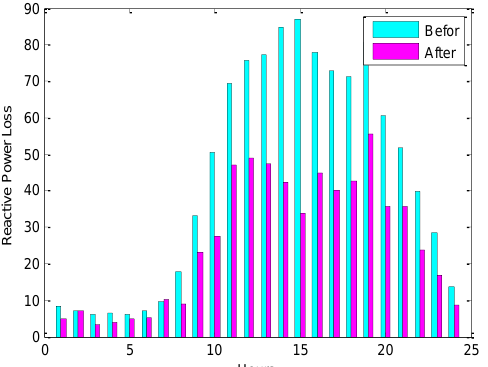
Figure 19. Reactive power losses for 24 h (second scenario).